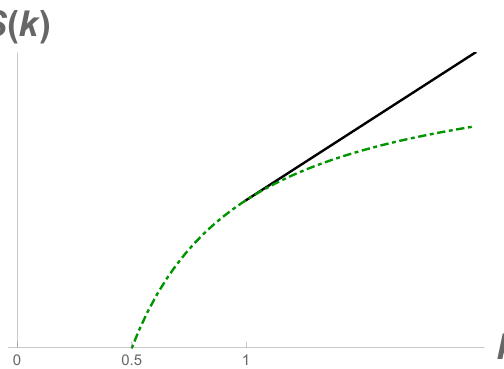
Figure 1 . The behavior of the entropy S at high energies, as a function of the WZW level k . The black solid line is the entropy of black holes, which do not exist for k < 1. The dashed line is the entropy of long strings, that dominate for k < 1 (see [1] for